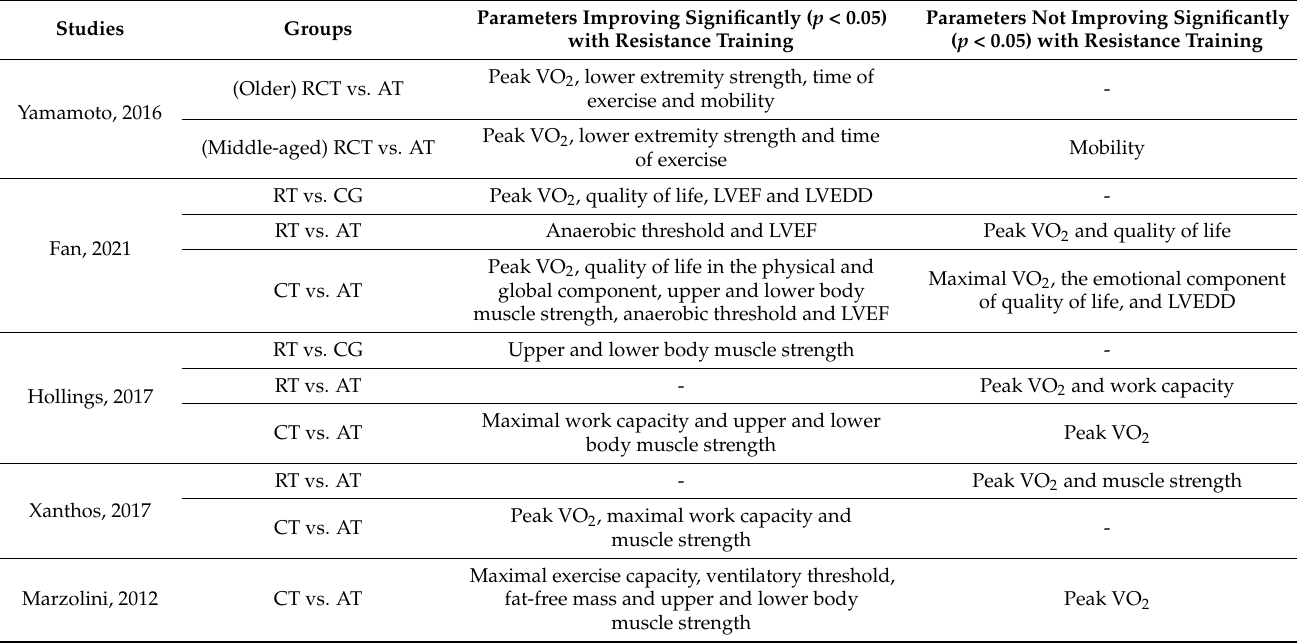
Table 2. Effects of resistance training in patients with coronary artery